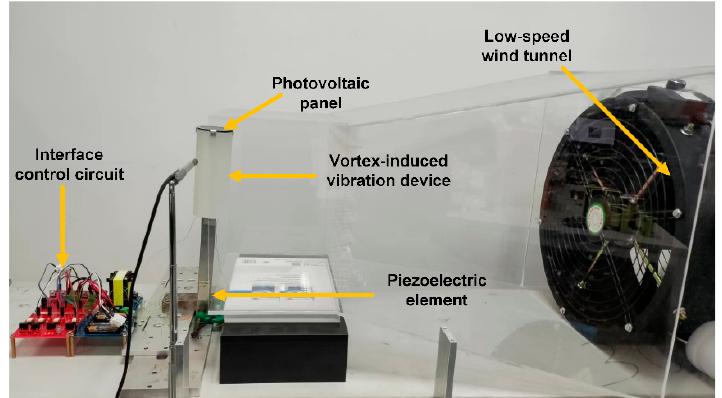
Figure 10. Platform of the wind-induced vibration–solar hybrid energy extraction device.